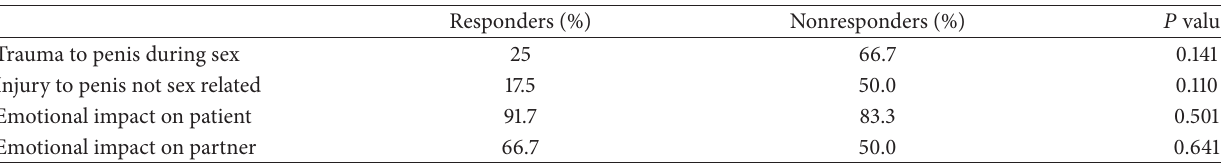
Table 2: History of trauma to the penis and emotional impact following Peyronie’s disease among responder and nonresponder men and their partners, expressed as